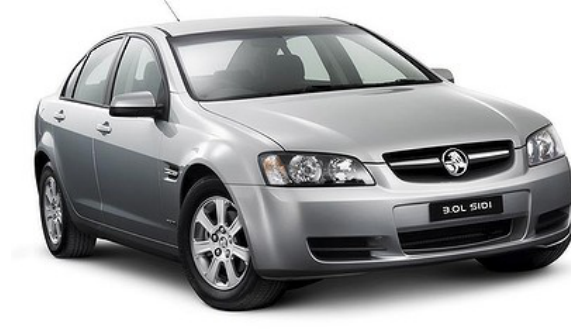
Fig. 1. Test vehicle: 2010 General Motors Holden Commodore Omega